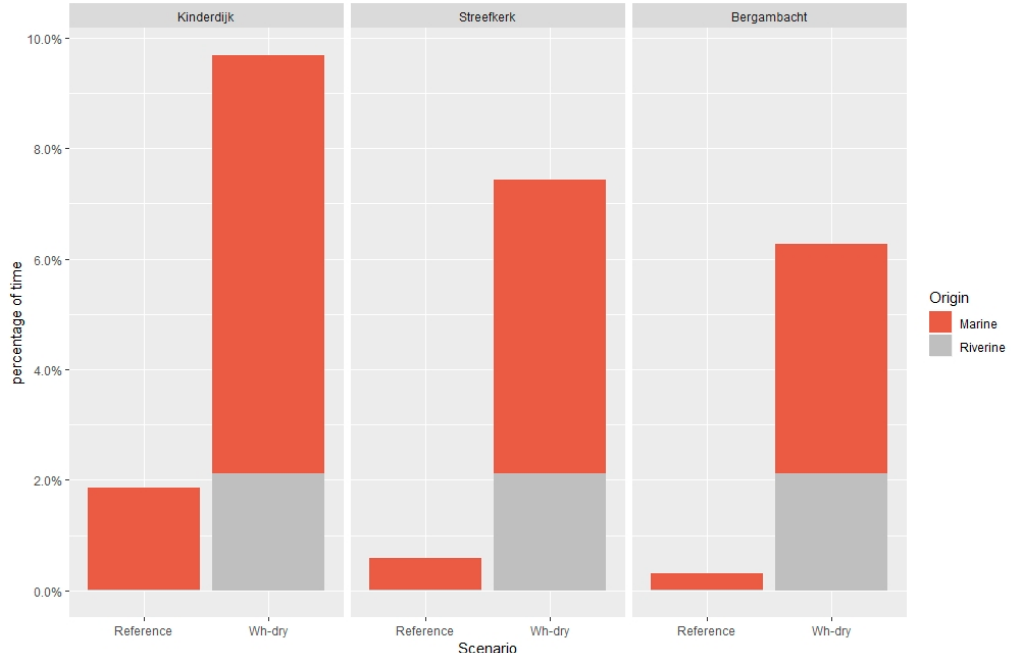
Figure 7. Exceedance of the maximum allowable chloride concentration at the three drinking water inlet locations, based on model calculations 1961–2011, under current conditions (Reference) and Wh-dry conditions. The threshold level is 150 mg/L. Exceedance of the threshold level can be due to a high riverine concentration in the river water (> 150 mg/l) or to enhanced seawater intrusion (marine).